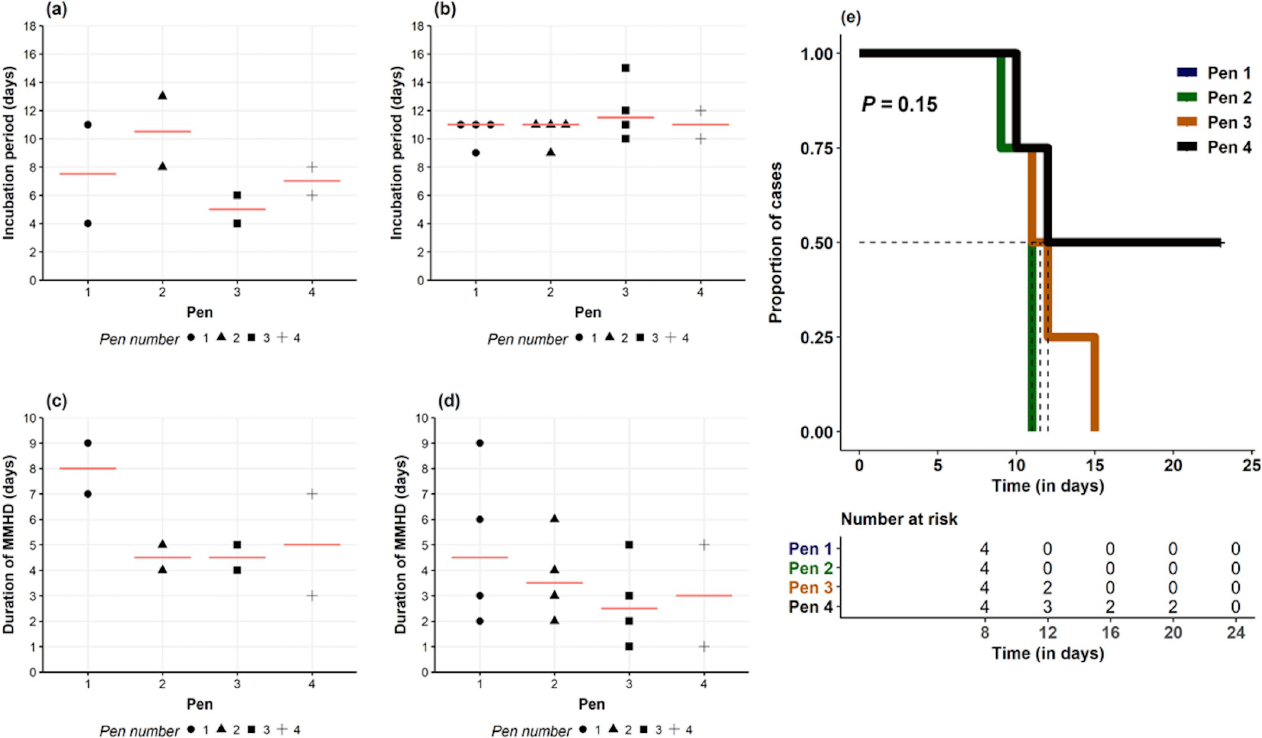
Fig 4. Trial 2 disease incubation, duration and survival in clinically affected seeder and contact pigs. (a) Incubation period in seeder pigs calculated pigs from intragastric reinoculation with B . hampsonii to onset of mucoid or mucohemorrhagic (MMHD), (b) incubation in contact pigs calculated pigs from onset of natural exposure to seeder pigs to onset of MMHD. Duration of mucoid or mucohemorrhagic diarrhea (fecal score � 3) in clinically affected seeder (c) and contact (d) pigs. Median values are showed as a red horizontal line. (e) Kaplan Meier survival curve for time to presentation of MMHD in contact pigs in pens 1 (blue line), 2 (green line), 3 (orange line), and 4 (black line). Pens 1 and 2 followed the same distribution pattern. Each pen contained 4 contact and 2 seeder pigs after regrouping (2:1 ratio). No statistical pen differences in the duration were observed in either clinically affected seeder ( P = 0.32) or contact pigs ( P = 0.21). Note the lower incidence in pen 4 (2/4) when compared with the other